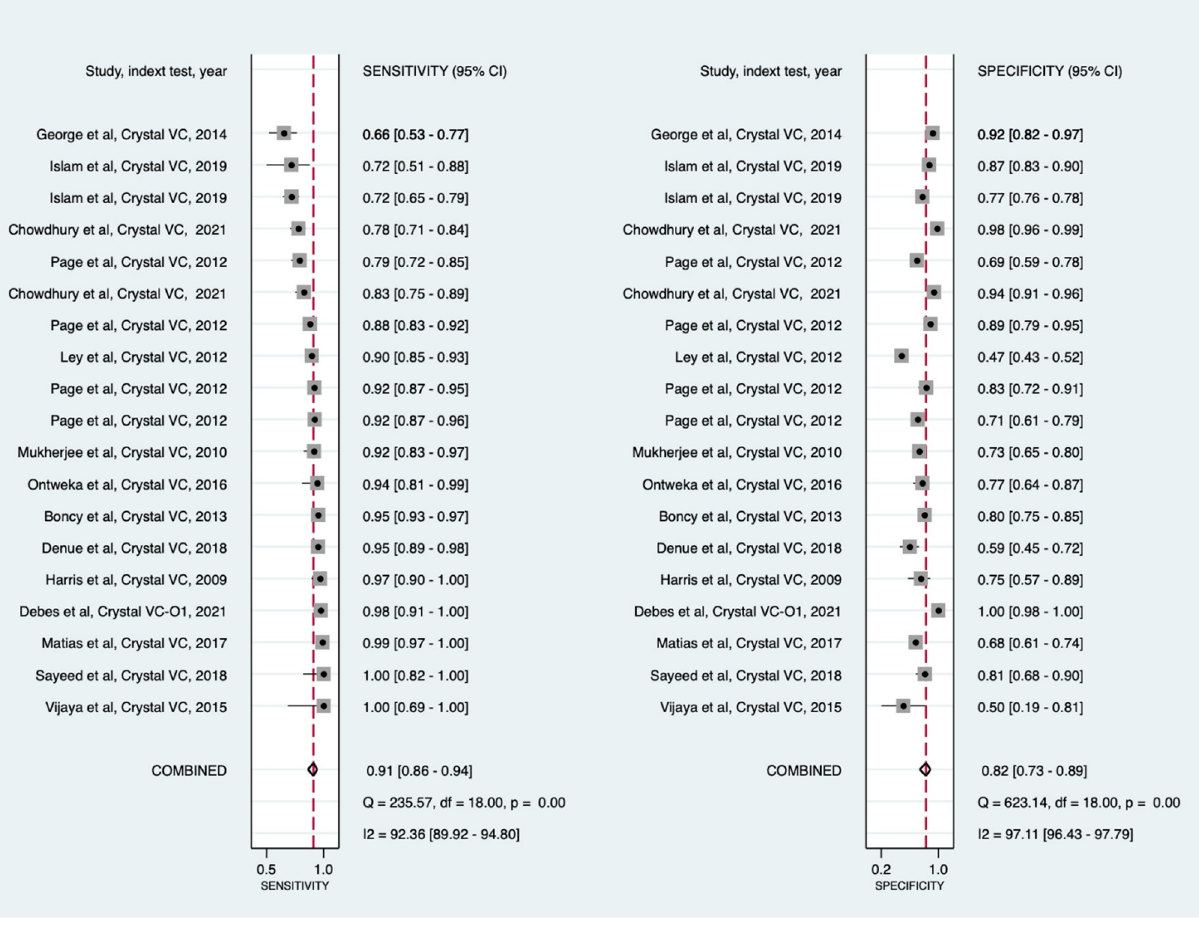
Figure 3. Forest plots of the sensitivities and specificities of Crystal VC cholera rapid diagnostic test for the detection of Vibrio cholerae O1 (direct stool testing).